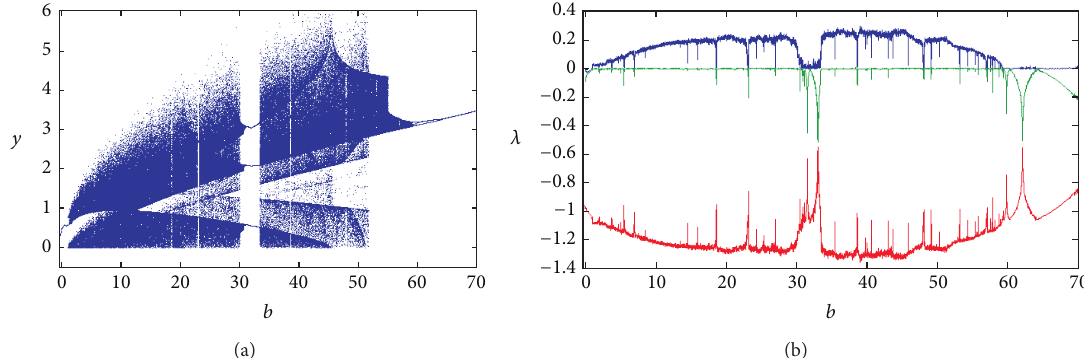
Figure 3: Nonlinear dynamics of system (1) for specific values 𝑎 = 1 , 𝑐 = 0.08 versus the control parameter 𝑏 . (a) Bifurcation diagram of 𝑦 . (b) Lyapunov exponent spectrum.